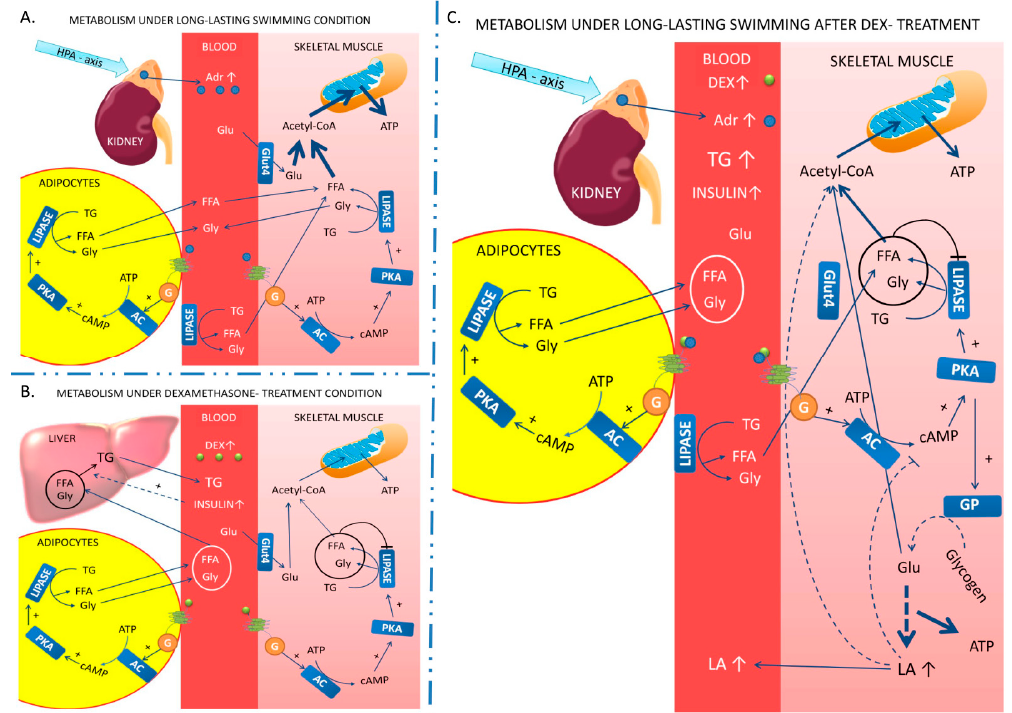
Figure 5. Potential mechanism(s) of action of swimming ( A ), Dex treatment ( B ), and a combination of these factors ( C ) on energy metabolism. of these factors ( C ) on energy